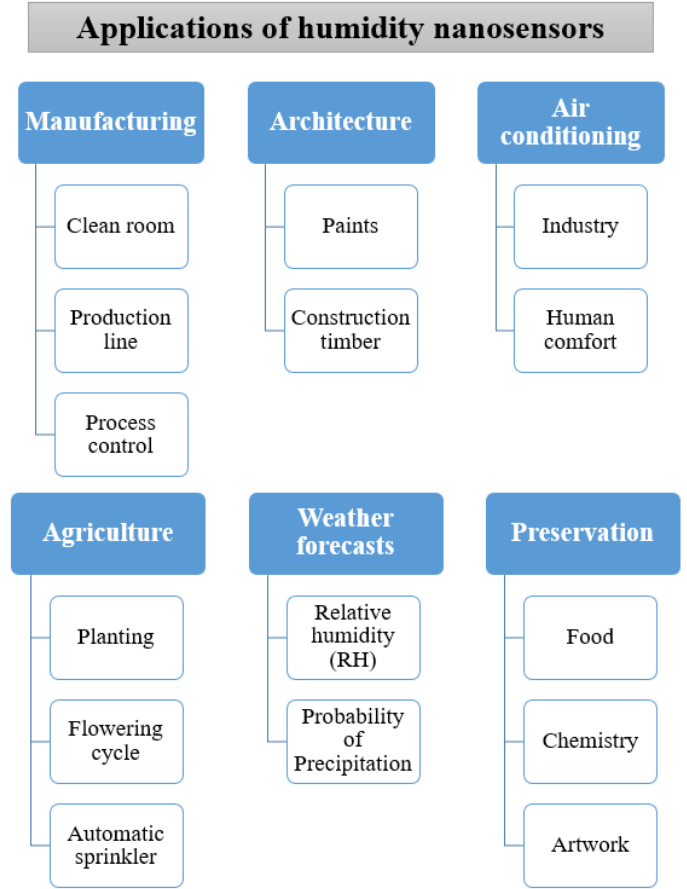
Figure 1. The applications of humidity nanosensors in our daily life.